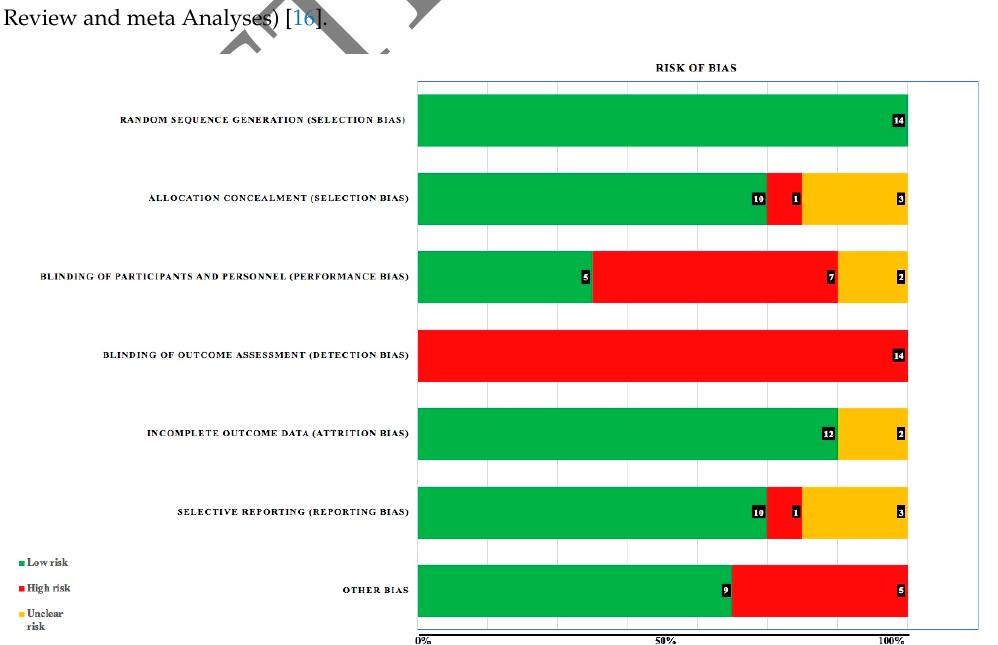
Figure 3. Risk of Figure 3. Risk of bias.